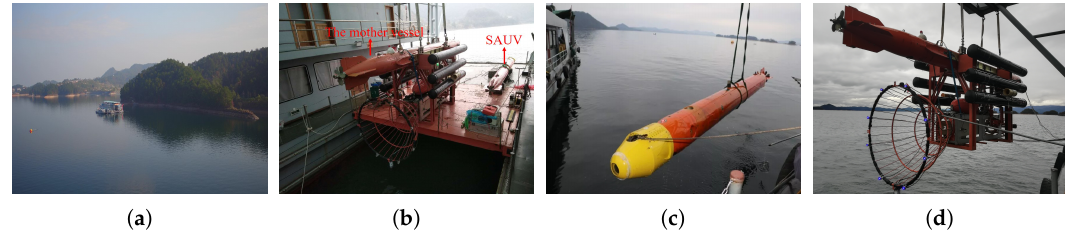
Figure 10. ( a ) Experiment ship in field experiments. ( b – d ) Mother vessel and sub-AUV (SAUV) in field experiments.